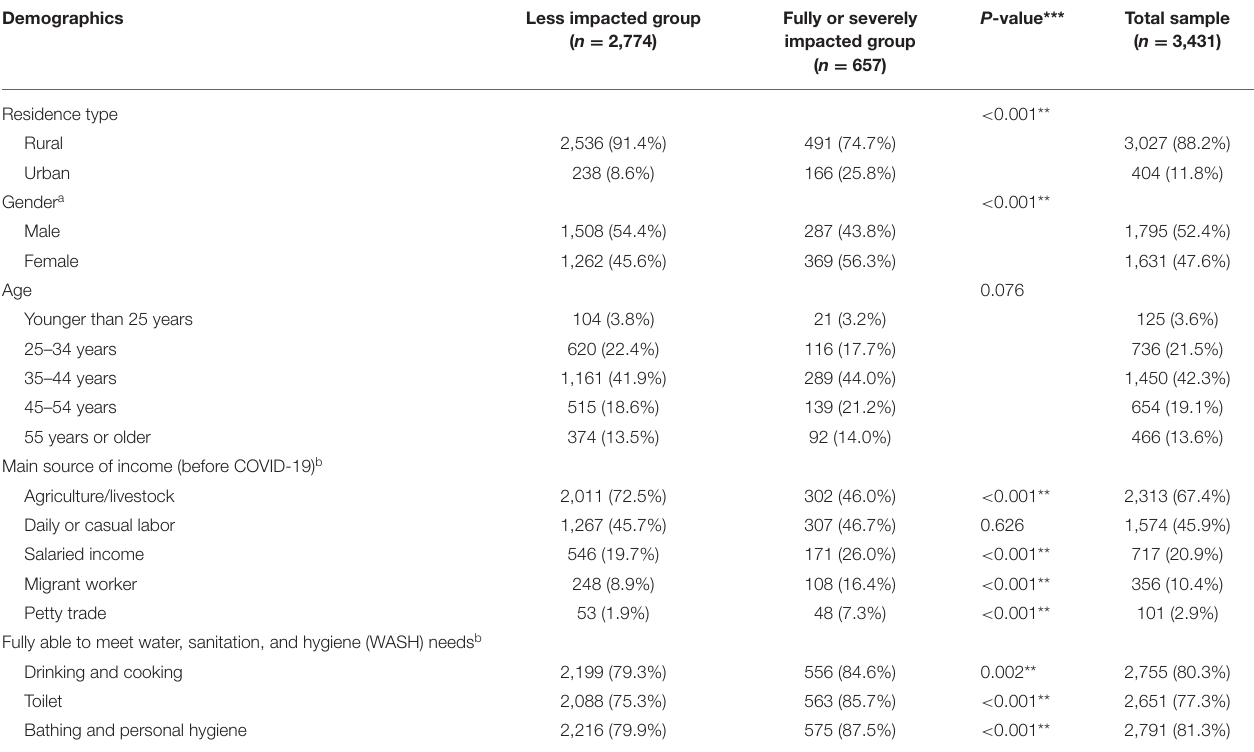
TABLE 1 | Background characteristics of the two livelihood